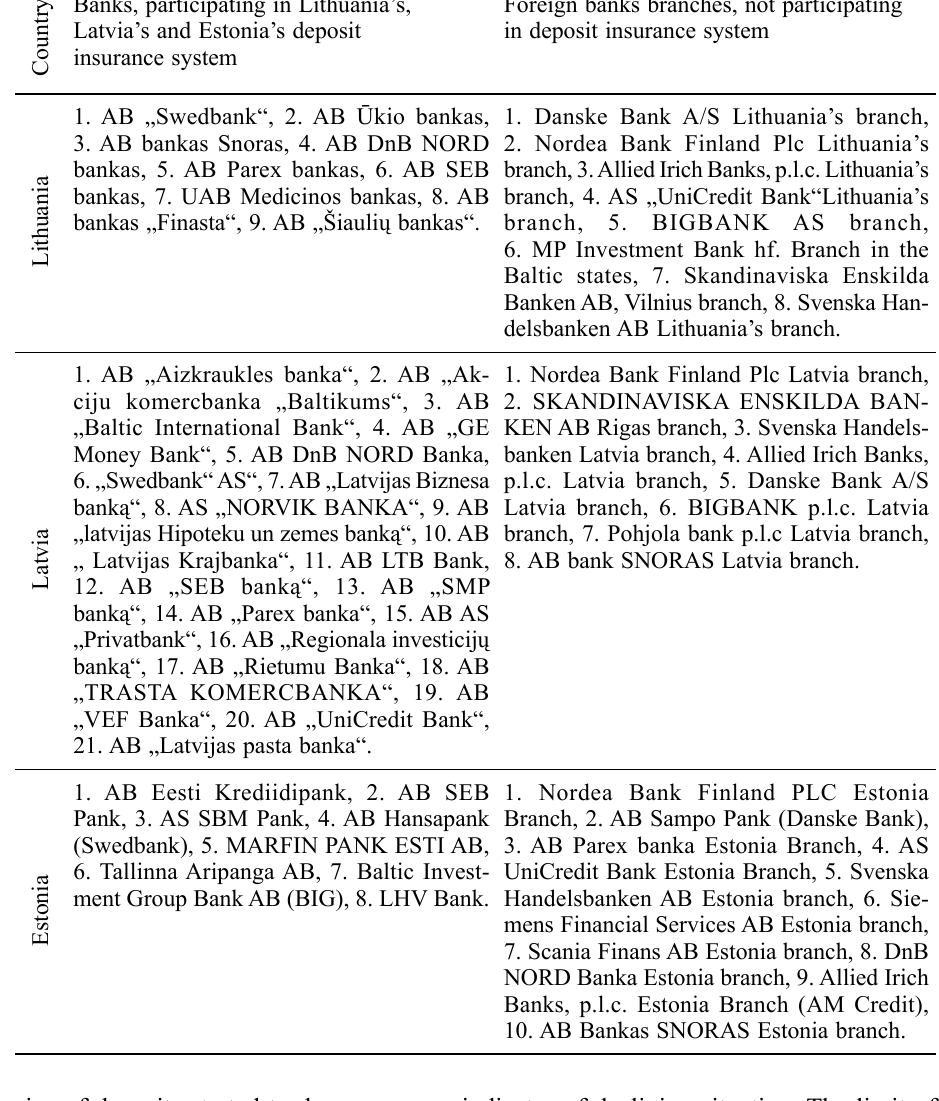
Table 4. Banks and branches of foreign banks operating in the Baltic States